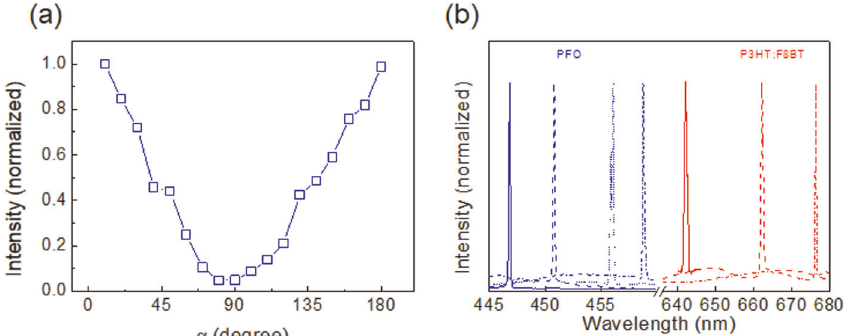
Fig. 6 a Polarized emission output of a DFB based on F8BT. The pump polarization was fi xed along the DFB lines, whereas the output intensity was fi ltered with a polarizer at different angles ( α ). b Normalized output spectra of PFO and P3HT:F8BT DFB structures above threshold. PFO concentrations: 10 mgml − 1 (blue solid line line), 20 mgml − 1 (blue dash line), 30 mgml − 1 (blue short dot line), and 40 mgml − 1 (short dash dot line). P3HT:F8BT concentrations: 10 mgml − 1 (red solid line line), 20 mgml − 1 (red dash line), and 40 mgml − 1 (red short dash dot line). The corresponding PFO fi lm thicknesses were 142, 178, 206, and 232 nm, as measured by AFM. The corresponding P3HT:F8BT fi lm thicknesses were 120, 180, and 260